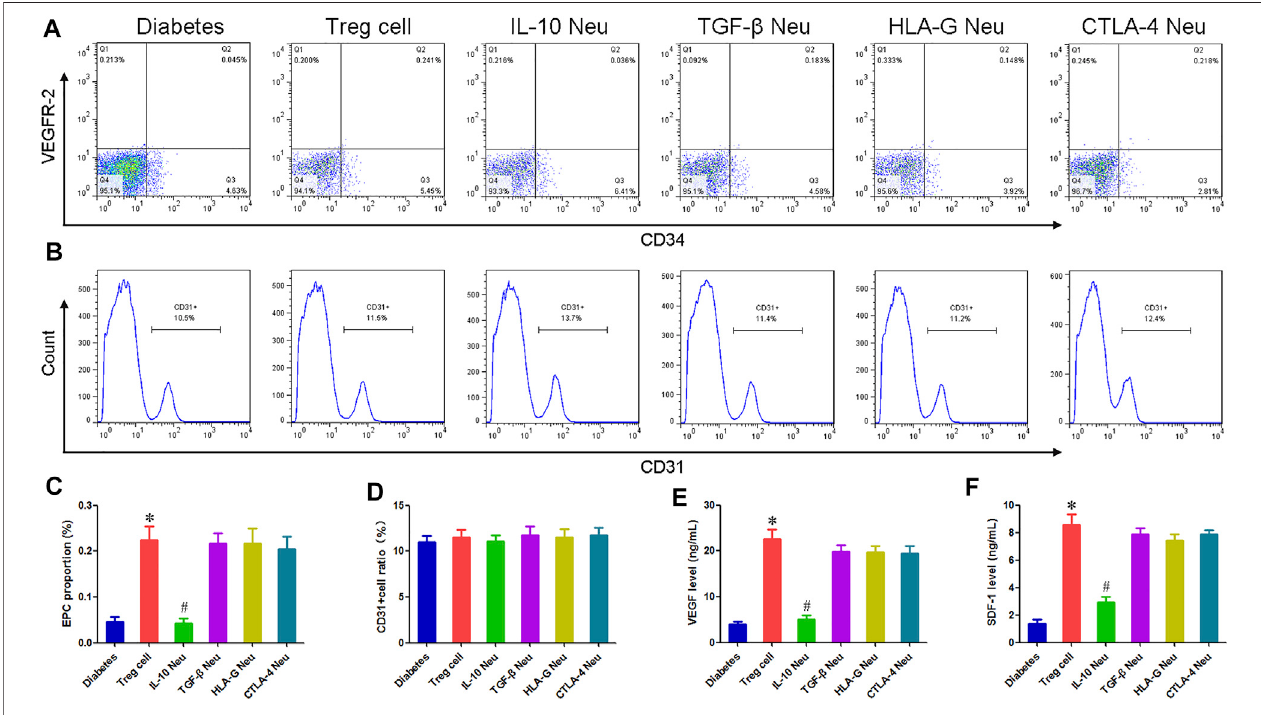
FIGURE 5 | Effect of Treg cells on EPCs function in diabetic patients. (A,B) Flow cytometry was used to detect the proportion of EPCs and CD31 + cells. (C) Compared with the diabetes group, the proportion of EPC in the Treg cell group increased markedly. IL-10 neutralization could inhibit this effect on Treg cells. (D) There wasnostatisticaldifferenceintheproportionofCD31 + endothelialcellsamongallgroups. (E,F) Comparedwiththediabetesgroup,theconcentrationofVEGFandSDF- 1 in the EPC supernatant of the Treg cell group increased by 4.75 and 5.13 times, respectively. IL-10 neutralization can inhibit these effects of Treg cells. * p < 0.05 ( n = 6) versus Diabetes group. # p < 0.05 ( n = 6) versus Treg cell group. Values are mean ±